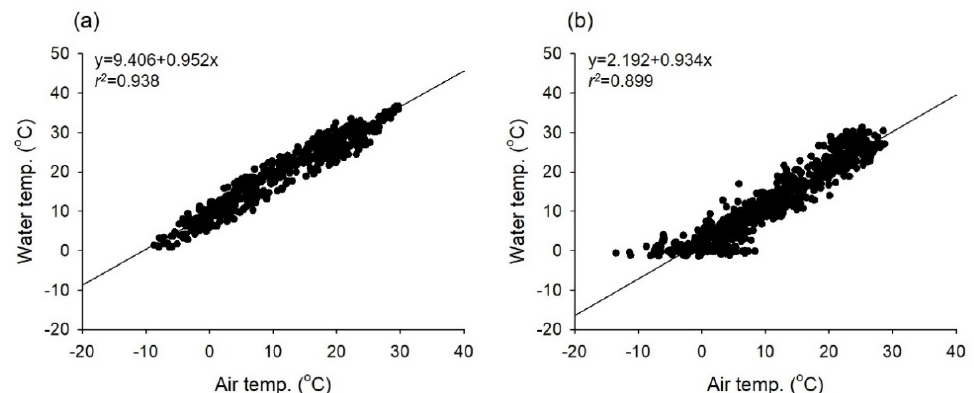
Figure 4. Correlation between air temperatures from weather stations and water temperatures recorded using data loggers: ( a ) MG; June 2006 − 2007, and ( b ) MU; 2019 − 2021.